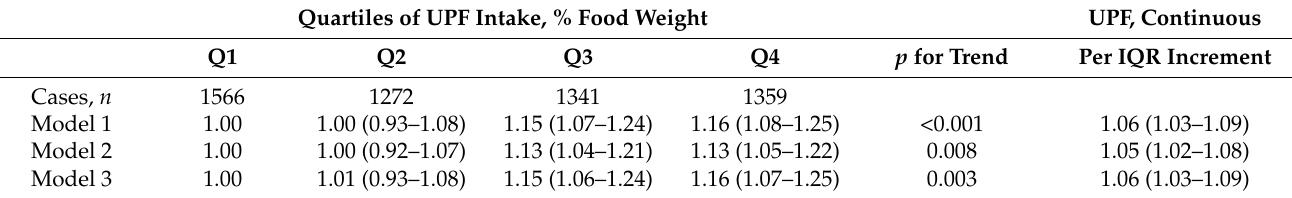
Table 2. Prevalence ratios of decreased kidney function (eGFR < 60) according to UPF intake.